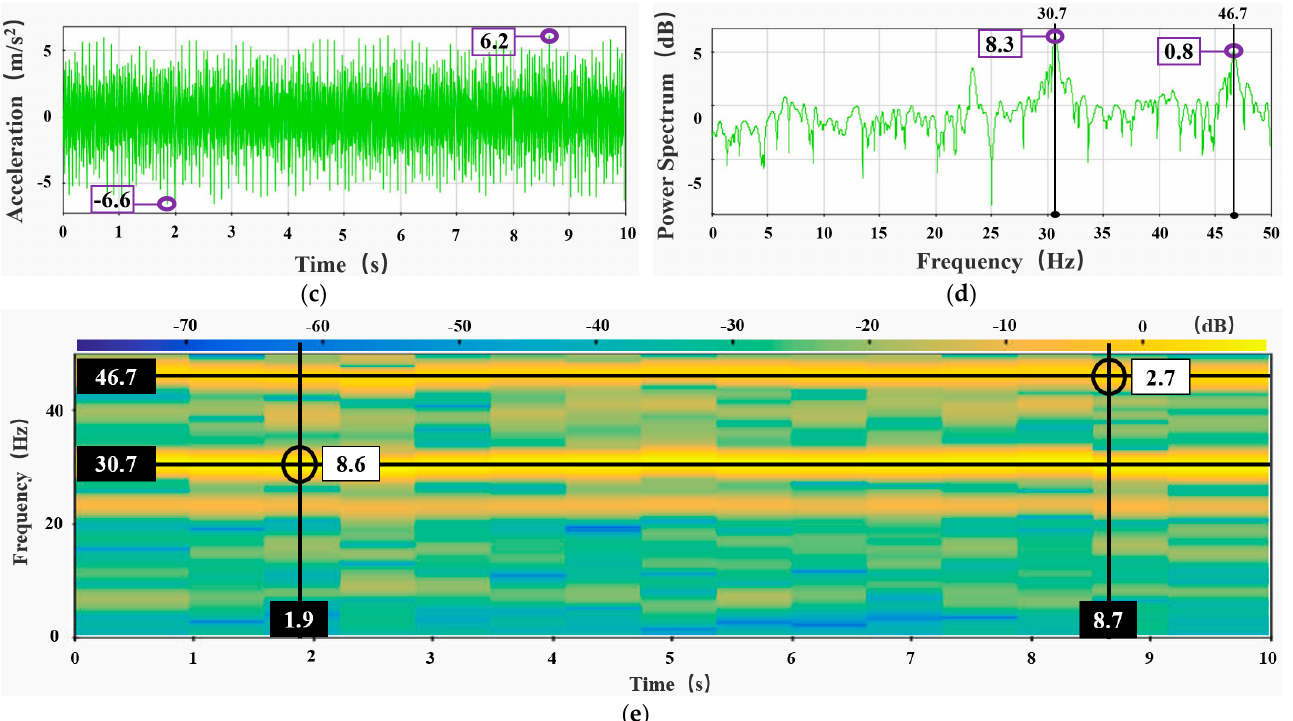
Figure 10. Results of the static no-load test on the carrier platform of the chipper: ( a ) three-way time-frequency diagram; ( b ) three-way amplitude-frequency diagram; ( c ) time-frequency diagram in the z-direction; ( d ) amplitude-frequency diagram in the z-direction; ( e ) time-frequency domain diagram in the z-direction.